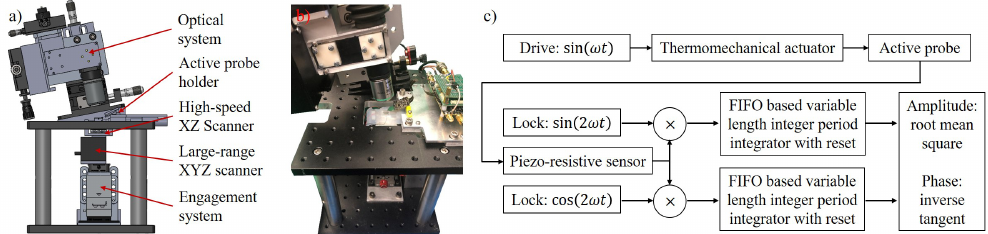
Figure 4. AFM system setup overview ( a ) design of the AFM with subsystem labeling in Solidworks software, ( b ) picture of the assembled AFM setup, ( c ) block diagram of the new FPGA based